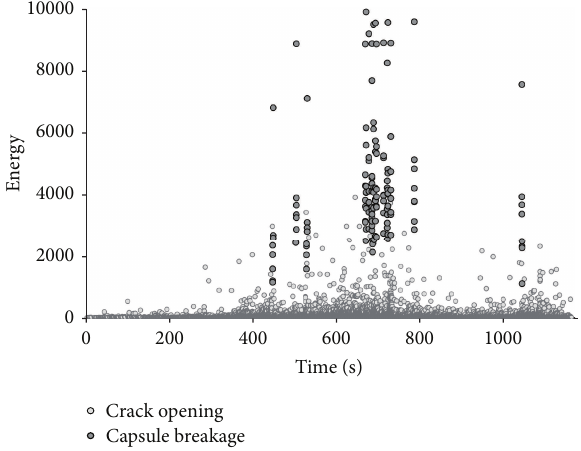
Figure 9: Hits energy activity during testing-detection of capsule breakage high energy hits.